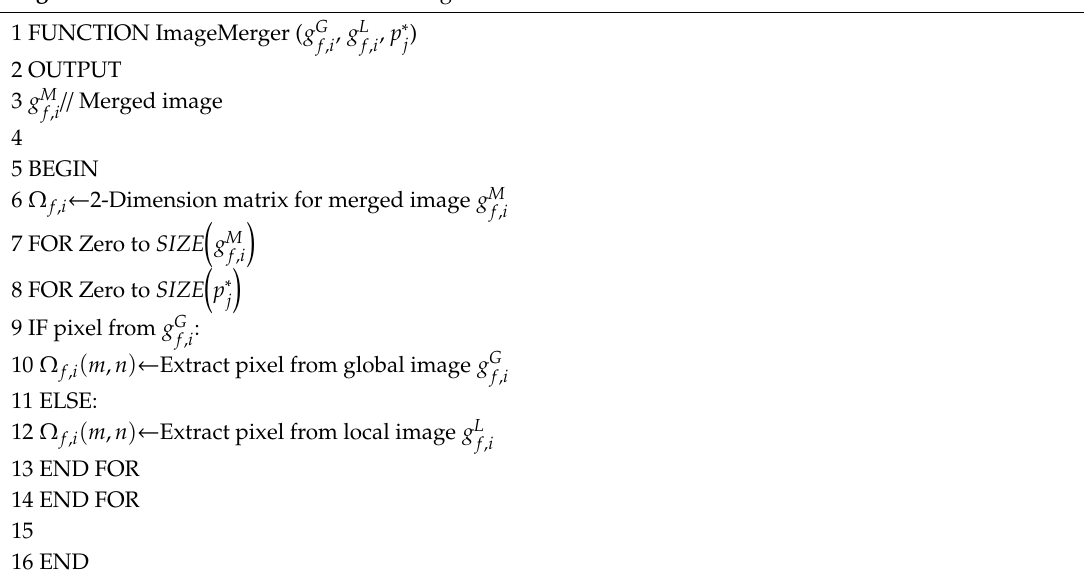
Algorithm 1 Local Feature Visualization